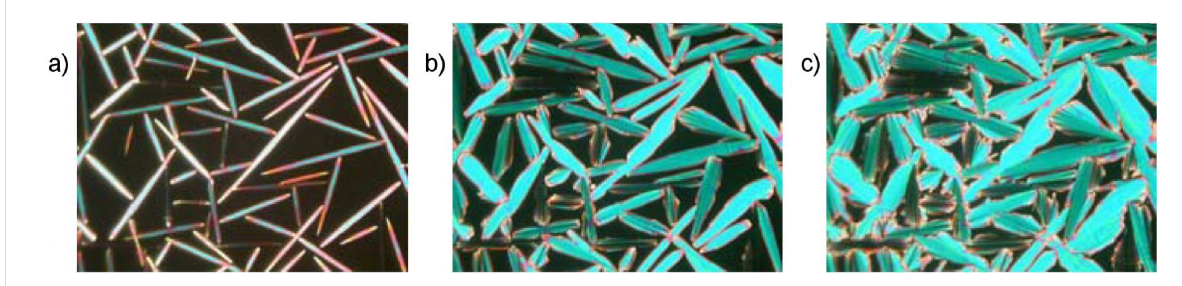
Figure 10: Growth of a fan-shaped texture from lancetlike filaments upon cooling of the isotropic liquid of compound OH 3b .